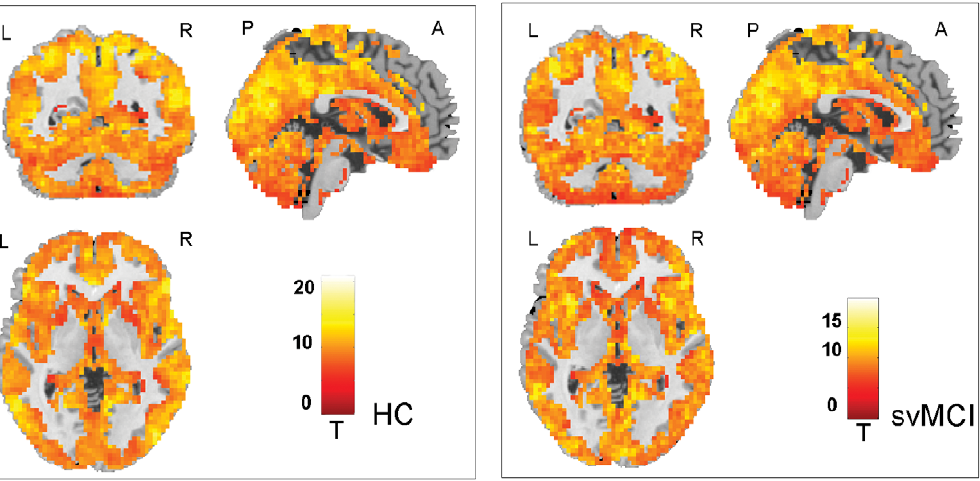
Figure 3. Within-group functional connectivity maps of the HC (left) and svMCI (right) groups. Widely spread regions of parietal, frontal, occipital and temporal lobes exhibited high functional connectivity values in the both groups. Note that the posterior cingulate (PCC) and adjacent precuneus (PCu) showed the highest functional connectivity density in the both groups. The statistical threshold was set at P , 0.001 for individual voxels and cluster size . 324 mm 3 , which corresponded to a corrected P , 0.01 determined by Monte Carlo simulations. L, left; R, right; P, posterior; A, anterior.